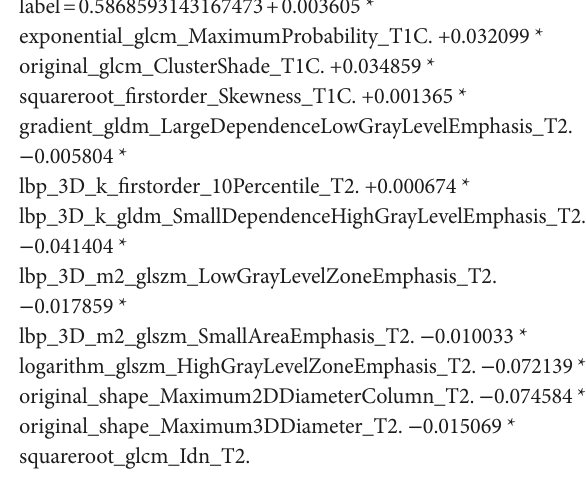
Figure 4C. The rad-score formula is as follows: